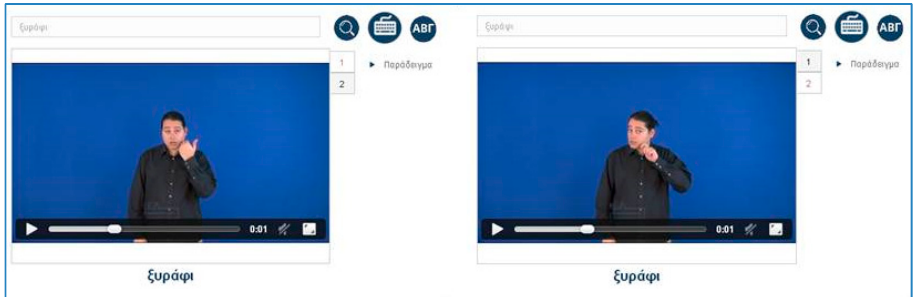
Figure 10. Modern Greek lemma “razor” presentation, with two forms (synonyms) in GSL in